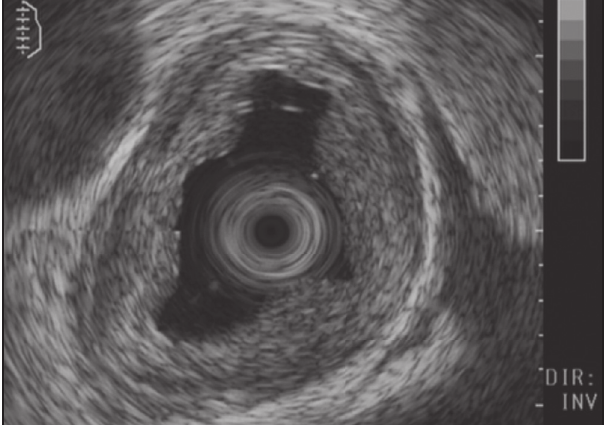
layer on black stripes with intact muscularis